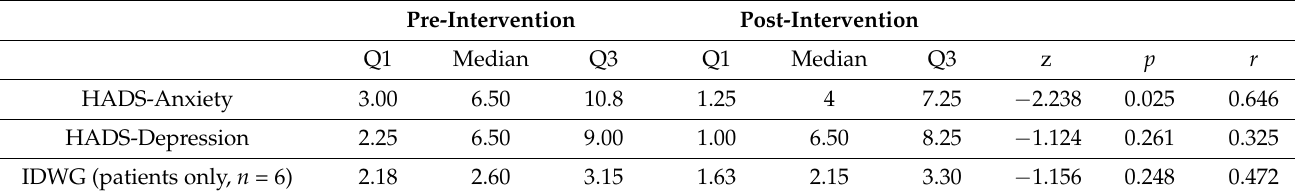
Table 3. Results from the Wilcoxon Signed-Ranked Test for pre and post-intervention scores ( n = 12 participants). Pre-Intervention Post-Intervention Q1 Median Q3 Q1 Median Q3 z p r HADS-Anxiety 3.00 6.50 10.8 1.25 4 7.25 − 2.238 0.025 0.646 HADS-Depression 2.25 6.50 9.00 1.00 6.50 8.25 − 1.124 0.261 0.325 IDWG (patients only, n = 6) 2.18 2.60 3.15 1.63 2.15 3.30 − 1.156 0.248 0.472 HADS = Hospital Anxiety and Depression Scale; IDWG = Interdialytic Weight